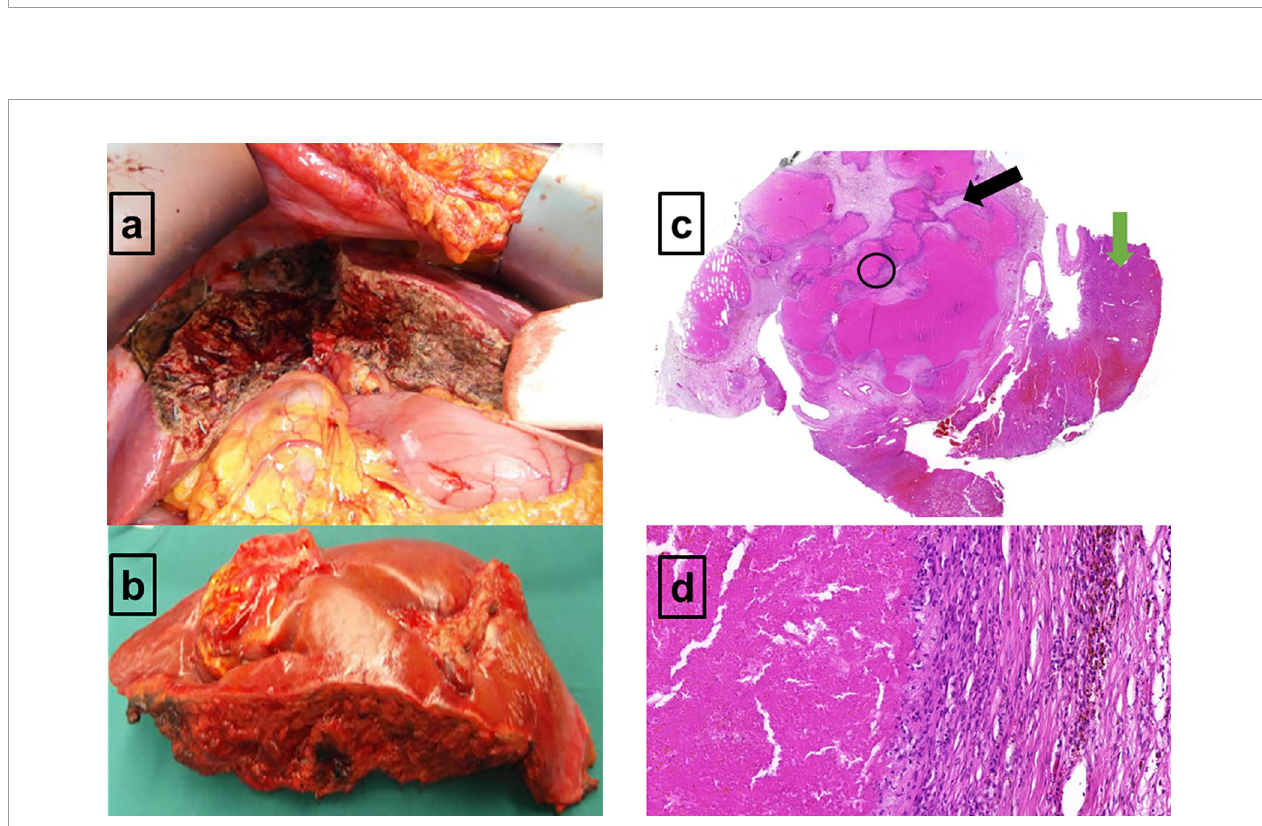
FIGURE 3 | Macroscopic and microscopic presentation of the 18 F-FDG-PET-positive residual in the right liver lobe (A – D) . (A) The in situ view demonstrates the liver segments V and VIII which are mostly necrotic and remodeled. (B) Macroscopic resectate of liver segments V and VIII. (C) Microscopic view of the liver resectate shows normal liver parenchyma on the right (green arrow) and extended area of necrosis on the left (black arrow). No evidence of large, polymorphous lymphoma cells. (D) Granulation zone with macrophages, small lymphocytes, and hemorrhagic remnants on the right, and an area of necrosis on the left ( D corresponds to a close-up of the black circled area visible on C ). No evidence of large, polymorphous lymphoma cells.